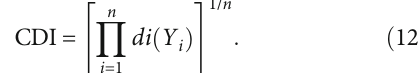
Table 2. The D eff values ranged from 1 : 5 × 10 − 9 to 4 : 4 × 10 − 9 m 2 /s for microwave-assisted air drying and 1 : 1 × 10 − 10 to 7 : 9 × 10 − 10 m 2 /s for blanch-assisted air drying.